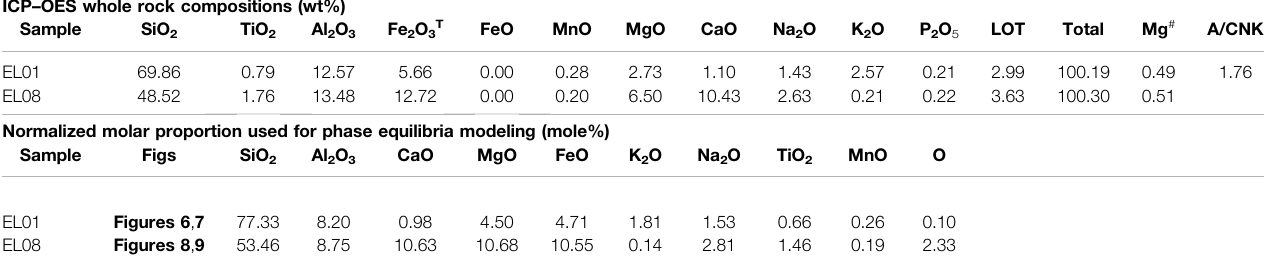
TABLE 1 | Bulk-rock compositions of the HP schists at Airgin Sum.